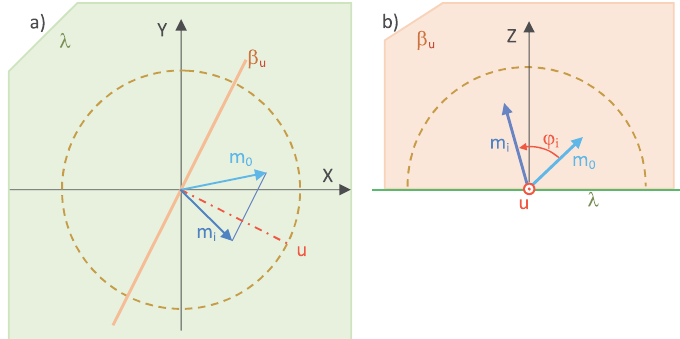
Figure 4. In the rotated system XYZ , the Listing’s plane λ is the XY plane. In ( a ) the projections of ˆ m 0 and ˆ m i on that plane are represented. The rotation axis ˆ u lays on that plane and is identified as the normal to the difference between the projections of ˆ m 0 and ˆ m i . The direction of ˆ u , together with the Z axis, identifies the plane β u . In ( b ) the projections of ˆ m 0 and ˆ m i on β u are shown: β u is the plane where the rotation angle ϕ i around ˆ u can be